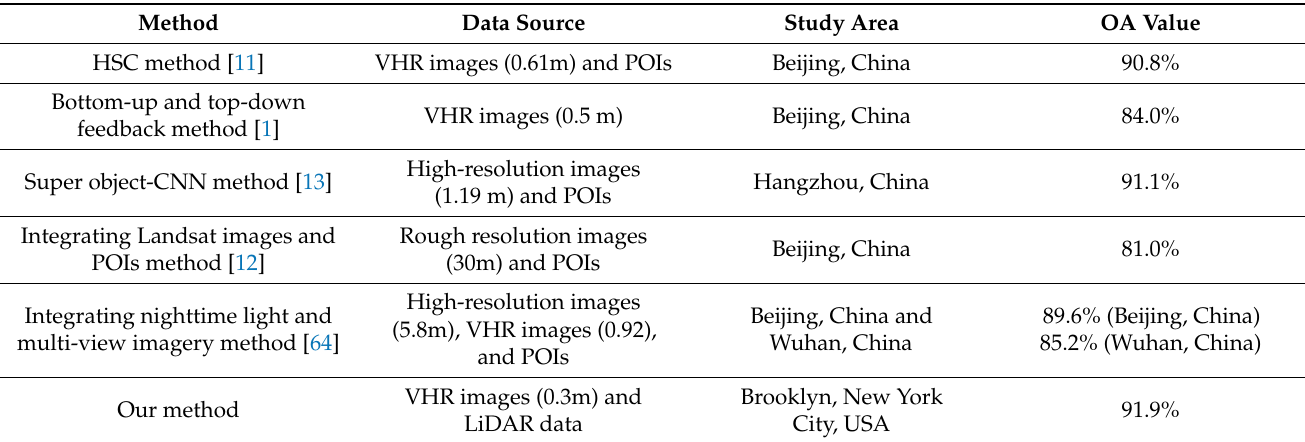
Table 9. Comparisons of the exist methods for UFZ